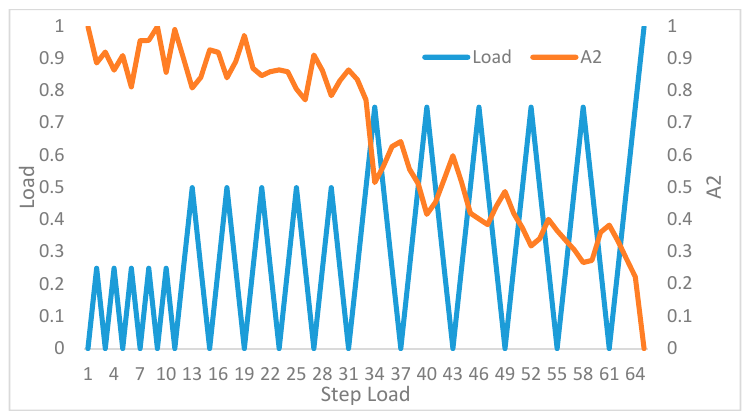
Figure 8. WC60C Specimen three: A2 versus load.